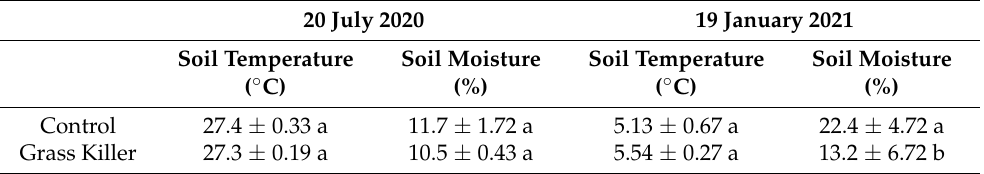
Table 5. The soil temperature and moisture at 10 cm depth were recorded on 20 July 2020 after the June test and on 19 January 2021, for the June and November test.